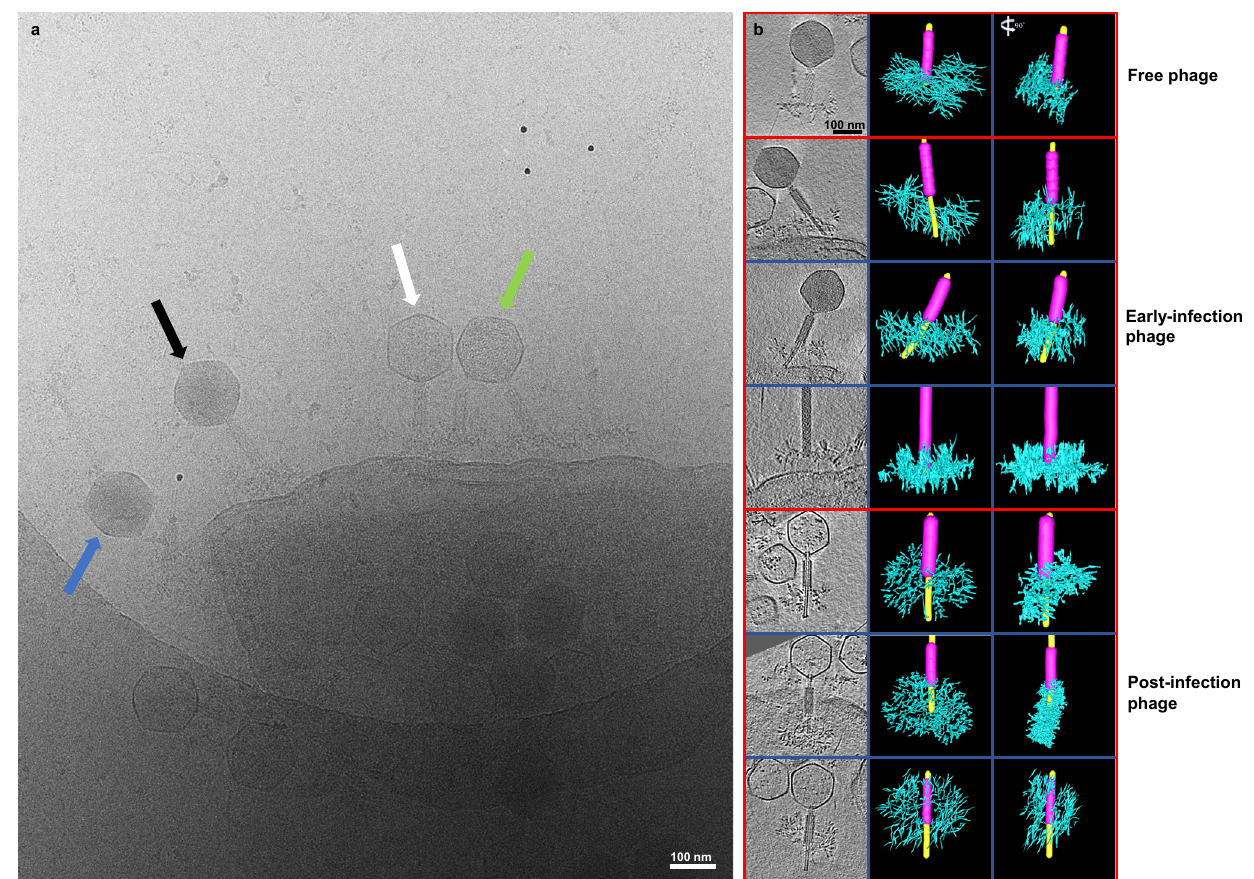
Fig.5|Cryo-ETofphage ϕ Kp24infecting K.pneumoniae andsegmentationsof tail fi bers. a 2D cryo-ET image showing several different states of phage ϕ Kp24 in its native environment: free phages (phages with dark capsids, blue arrow), early- infection phages (phages with dark capsids and attached to host membrane, black arrow), mid-infection phages (phages with half-dark capsids and attached to host membrane, green arrow), and post-infection (empty) phages still attached to the cell (white arrow). b Trimmed tomograms of phage ϕ Kp24 and manual segmen- tations. The fi rst column shows seven representative tomograms of ϕ Kp24 in